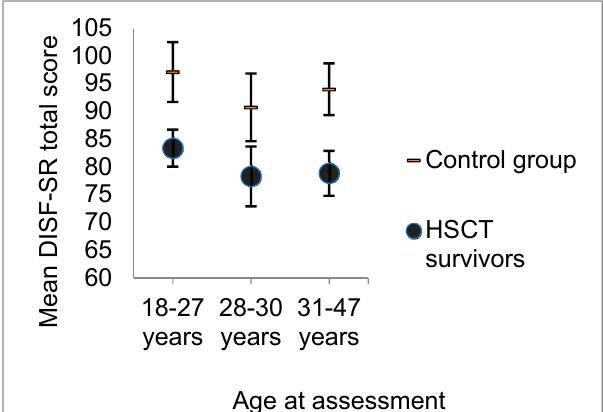
Figure 2. Mean total scores on the Derogatis Interview for Sexual Functioning self-report (DISF-SR) in HSCT survivors and their controls. Results are categorized according to age group. Sexual functions declined in a similar pace in both groups.